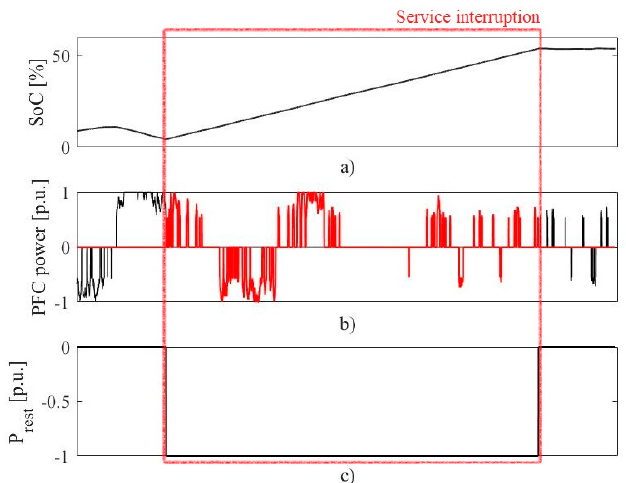
Figure 4. Schematization of state-of-charge (SoC) restoration strategy in the No Degrees of Freedom (DoF) case, with time on the x-axis: ( a ) SoC evolution; ( b ) power requested for FCR before, during and after the service interruption; ( c ), restoration power. Positive power means discharge. Red trend highlights that all the power requested while service is interrupted results in nonperformance (NP) and is accounted for NPP. Power is expressed per unit with respect to the nominal power of the battery.